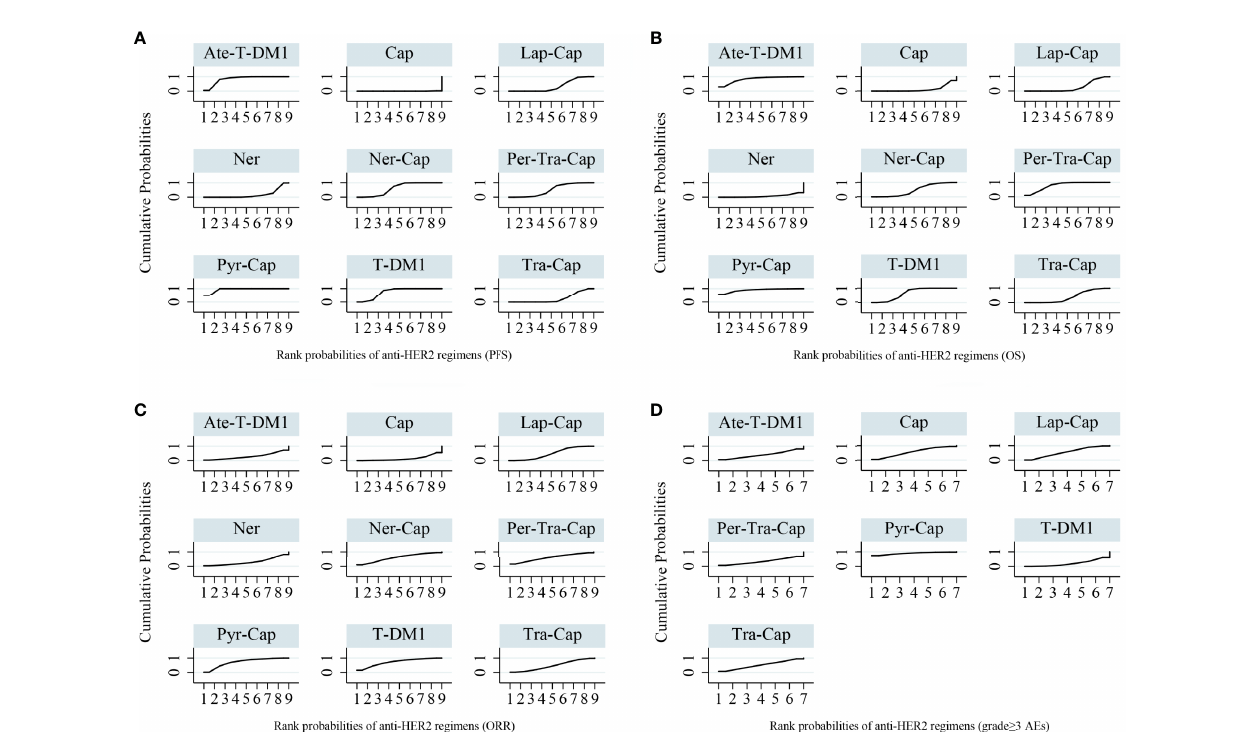
FIGURE 6 | Surface under the cumulative ranking curves (SUCRA) for anti-HER2 regimens of all outcomes. (A) PFS (B) OS (C) ORR (D) grade ≥ 3 AEs. PFS, progression-free survival; OS, overall survival; ORR, overall response rate; AEs, adverse events; T-DM1, trastuzumab emtansine; Lap, lapatinib; Tra, trastuzumab; Cap, capecitabine; Ner, neratinib; Per, pertuzumab; Pyr, pyrotinib; Ate,